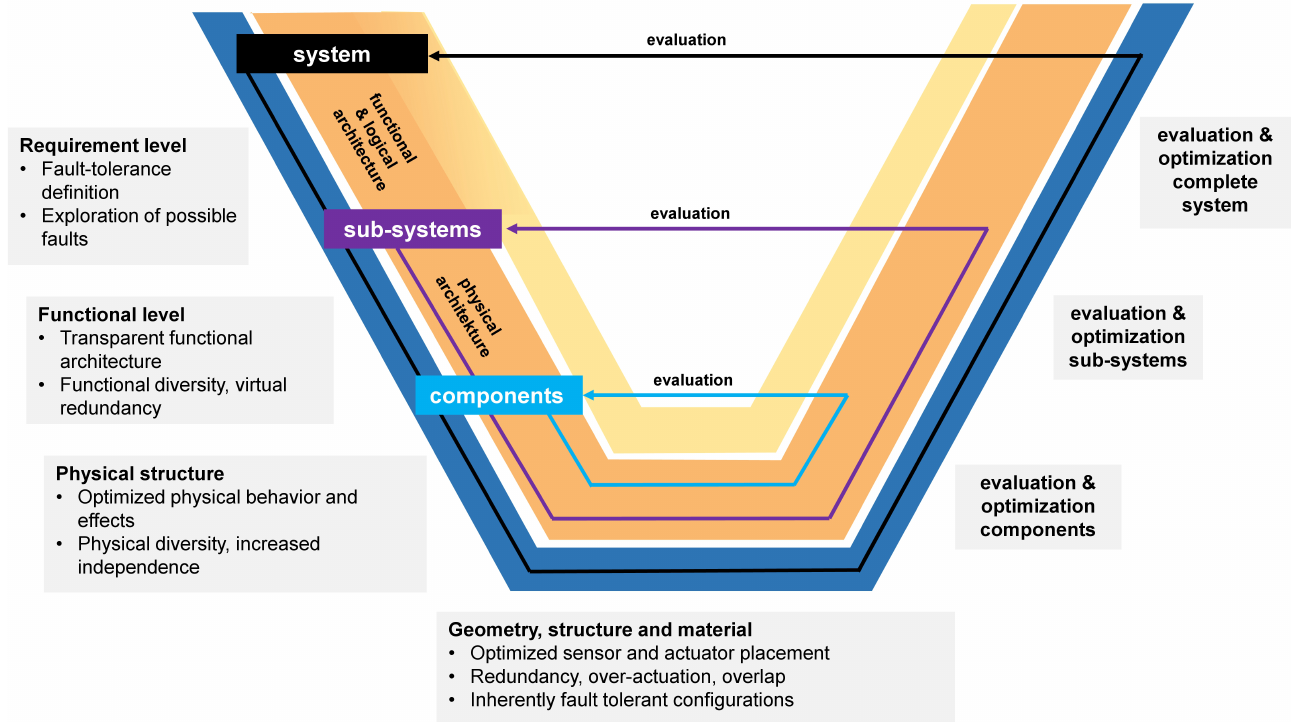
Figure 2. Levels for characteristics of fault-tolerant design according to the levels of product con- cretization depicted in a